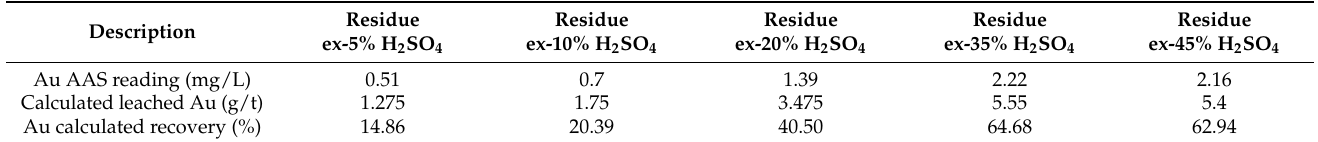
Table 10. Cyanidation stage: results of Au in solution.